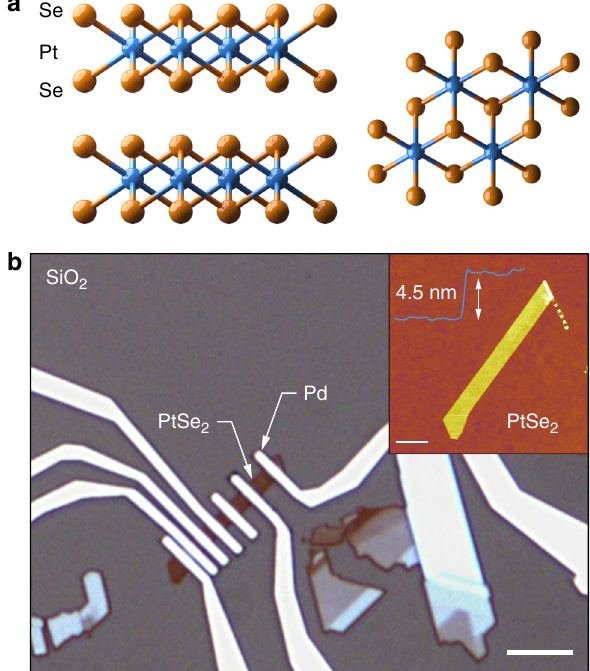
Fig. 1 PtSe 2 structure and devices. a PtSe 2 layered crystal structure showing two layers from side and top view. b Example of PtSe 2 crystal before (inset, AFM image, scale bar is 2 µ m) and after evaporation of Pd contacts (optical image). Scale bar is 5 µ